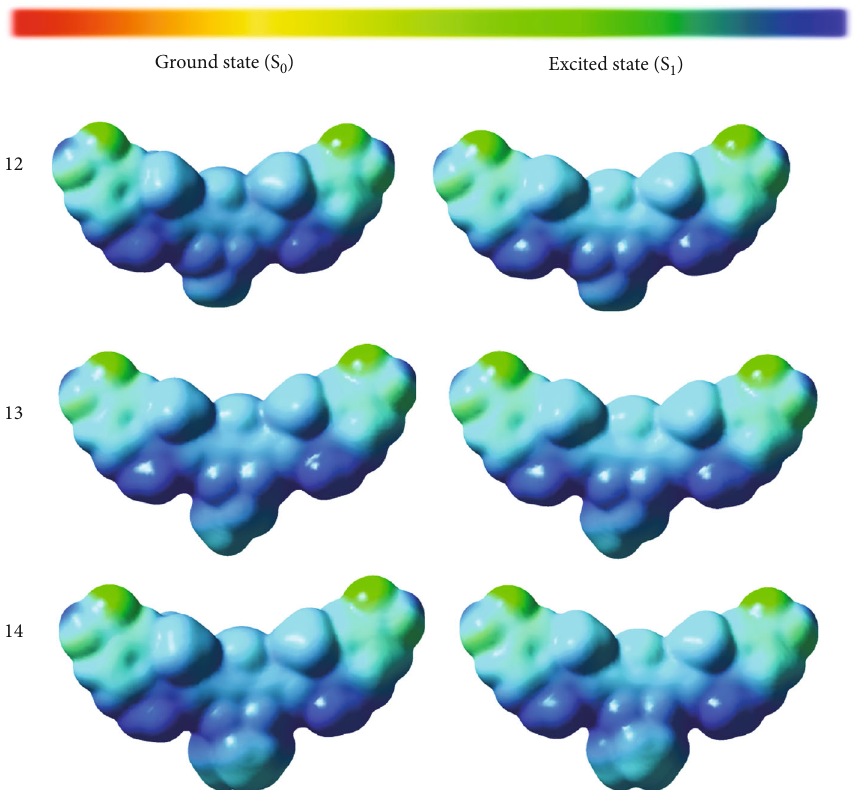
Figure 7: Electrostatic potential surfaces computed at M06-2X/6-311+G(d,p)//M06-2X/6-31G(d,p) in PCM/methanol for the dyes 12-14 in the ground and excited states.